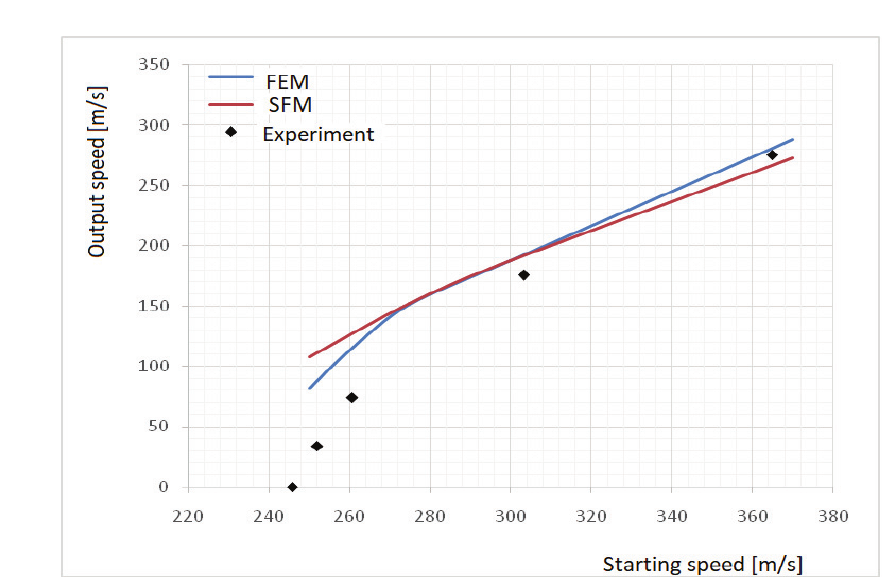
Figure 26 – Comparison of the results obtained with the FEM and SFM methods for an aluminum plate with a thickness of 20 mm, conical projectile Рис . 26 – Сравнительный анализ результатов , полученных FEM и SFM